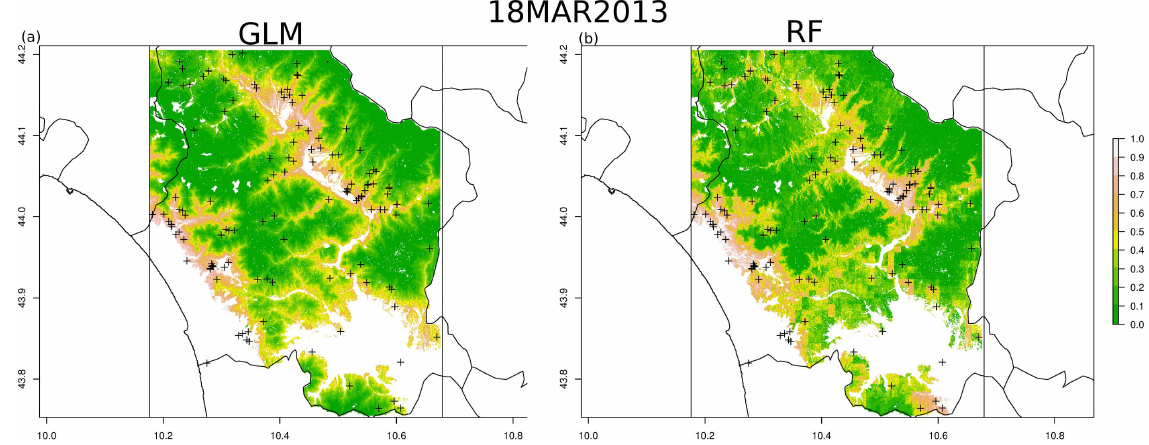
Figure 8. 18MAR2013 landslide hazard maps. Results from the GLM (a) and from the RF classifier (b) . Crosses points are the event inventory maps produced by field surveys a few days after the rainfall event.